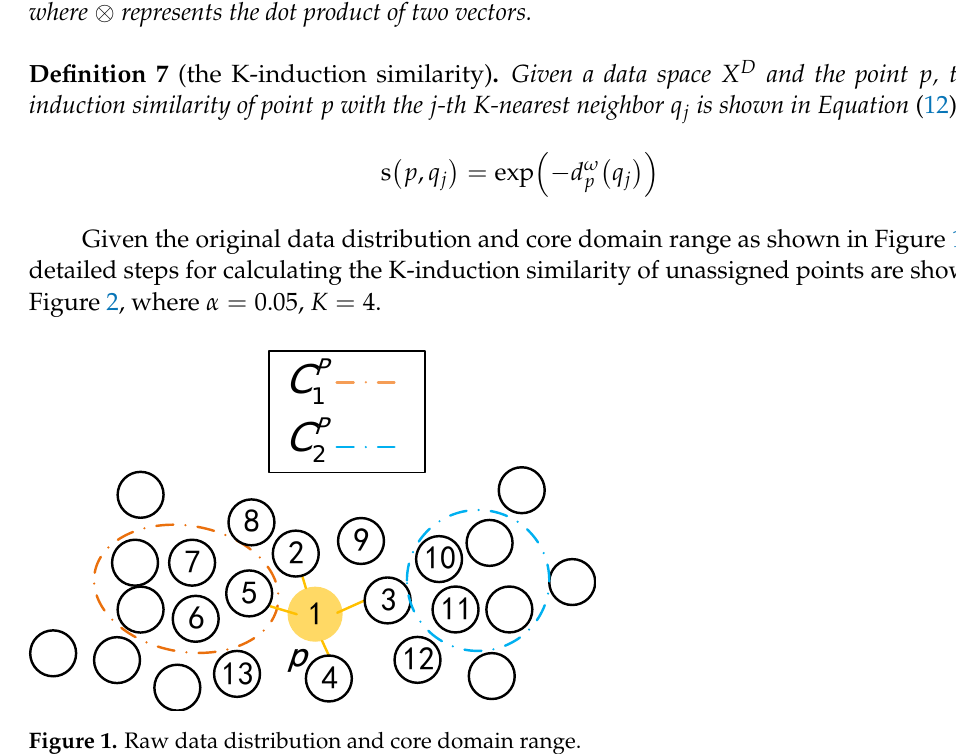
Figure 1. Raw data distribution and core domain